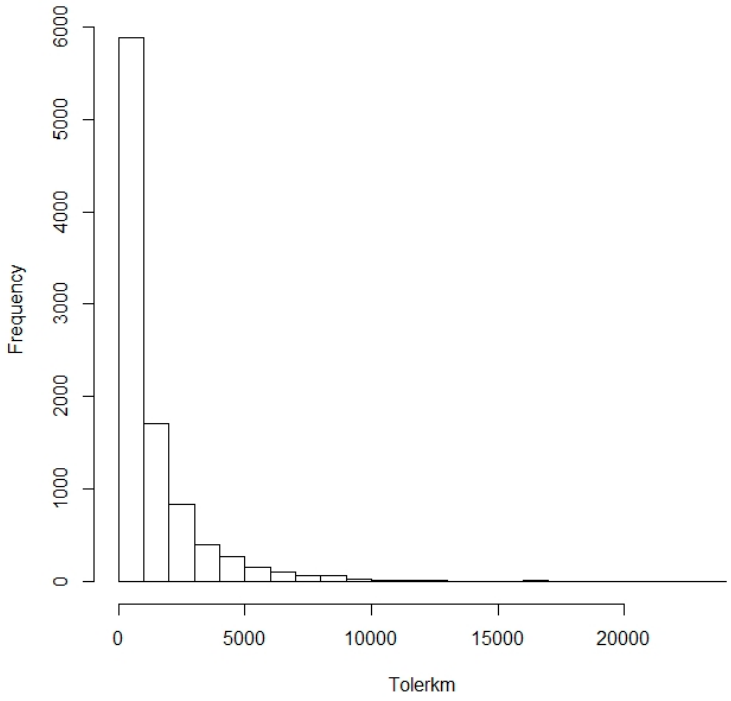
Figure 1. Histogram of the distance travelled at speeds above the limits. Table 3. Parameter estimates of the linear regression model.